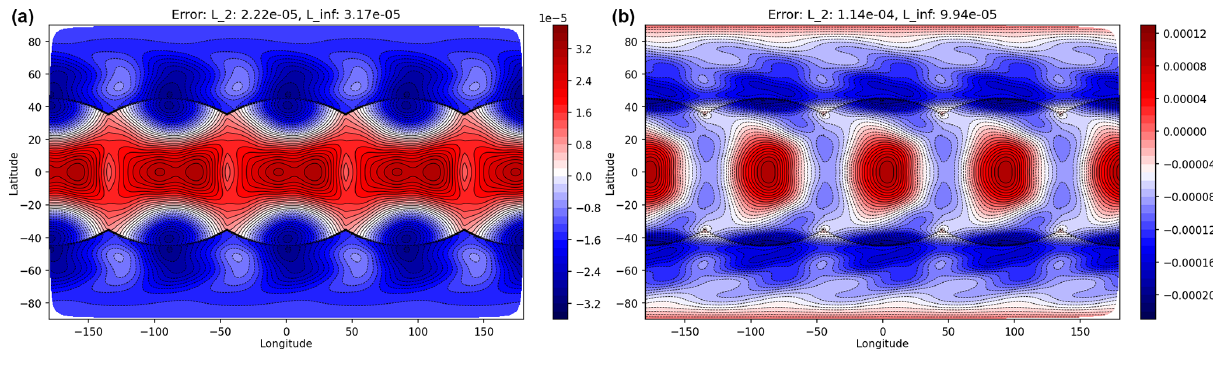
Figure 4. Errors after 15d for the Williamson 2 test at C96 resolution for geopotential (a) and zonal wind (b) showing the large-scale nature of the